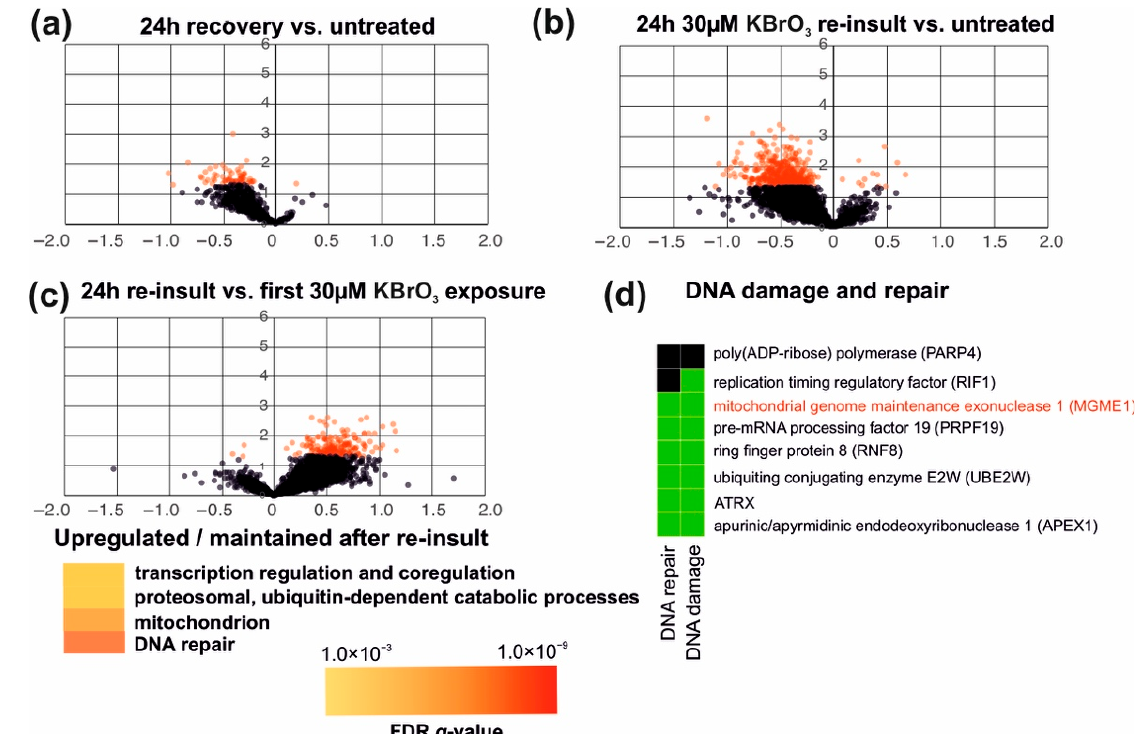
Figure 7. Hormetic effects in cells exposed to oxidative stress. ( a ) Gene expression differences between cells after 24 h recovery of 30 µ M KBrO 3 treatment and untreated controls. The x-axis indicates the fold change and the y-axis the inverse log10 t-test p -value. Genes with p -values below 0.05 are shown in red. The recovering cells still show several downregulated genes, but no specific pathways or processes are affected. ( b ) Retreatment with 30 µ M KBrO 3 after the recovery induces a similar, but milder reduction in gene expression as seen upon the first insult. ( c ) Retreated cells show the specific maintenance of pathways and cellular processes linked to gene expression, mitochondrial function and DNA repair. ( d ) Among the maintained DNA damage-associated genes are repair enzymes such as APEX1, but also the mtDNA-degrading exonuclease MGME1.